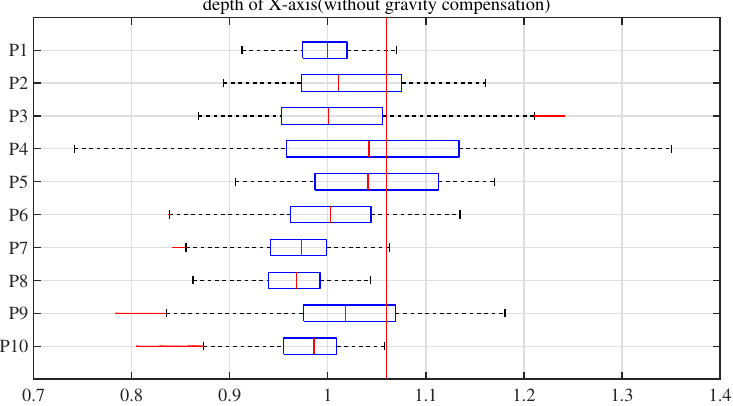
Figure 18. Distribution of the UW end-effector distance from the center of 10 subjects with gravity compensation of K-handler.